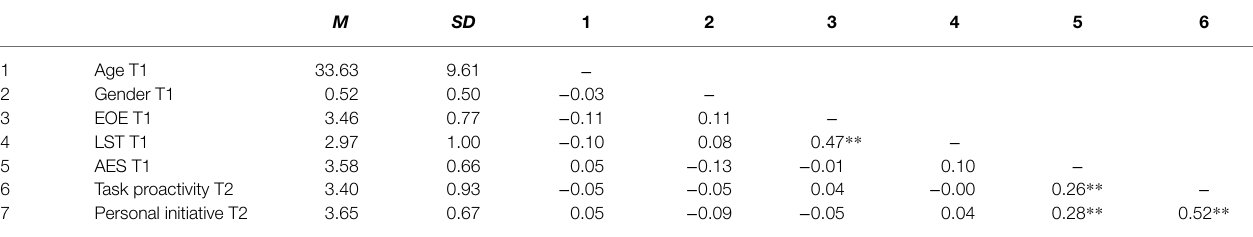
TABLE 1 | Means (M), SD, and correlations of the study variables in Study 1.